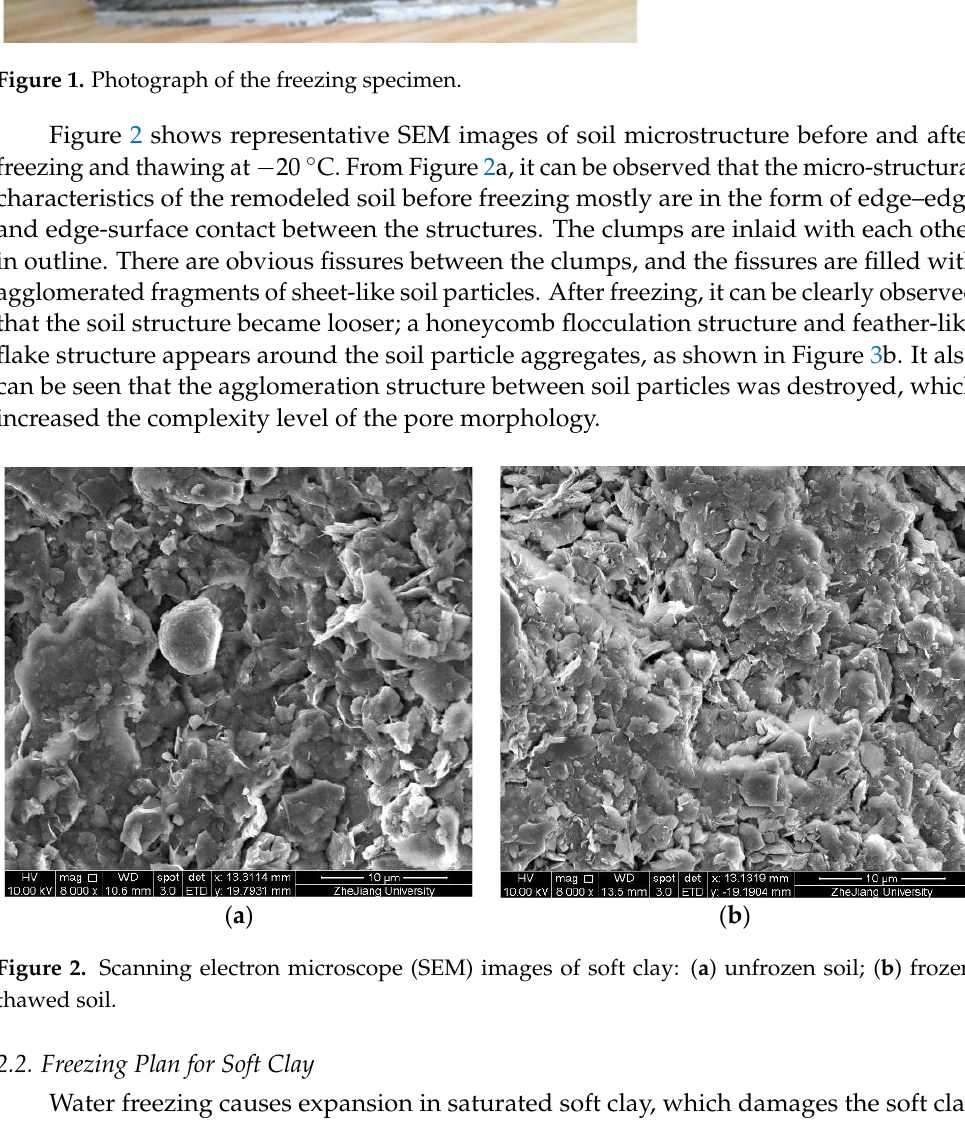
Figure 2. Scanning electron microscope ( SEM) images of soft clay: ( a ) unfrozen soil; ( b ) frozen- thawed soil.